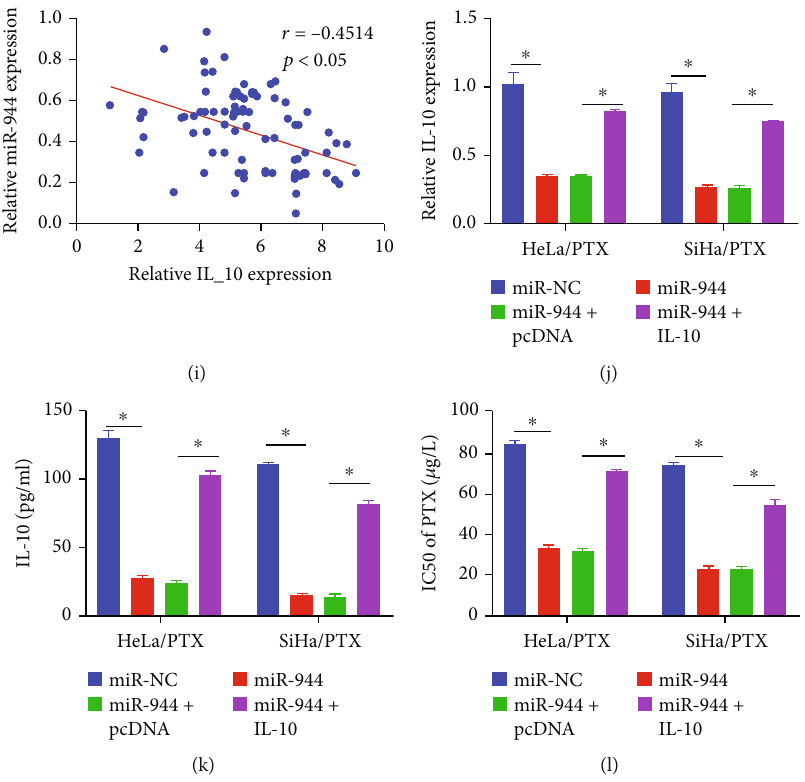
Figure 4: The targeting of IL-10 in PTX-resistant CC cells results in the overexpression of miR-944 and elevates PTX sensitivity. (a, b) The signi fi cant interaction sites between miR-944 and IL-10 determined by the DLR assay. (c) miR-944 expression was assessed via qRT-PCR. (d, f, j) The data obtained from qRT-PCR analysis to examine the expression level of IL-10. (e, g, k) The ELISA assay data to detect the expression level of IL-10. (h) The qRT-PCR evaluations for IL-10 level in CC tissues. (i) The correlation between IL-10 and miR-944 was estimated by Spearman ’ s correlation coe ffi cient analysis. (l) The IC 50 values of PTX in HeLa/PTX and SiHa/PTX cells. ∗ p < 0 : 05